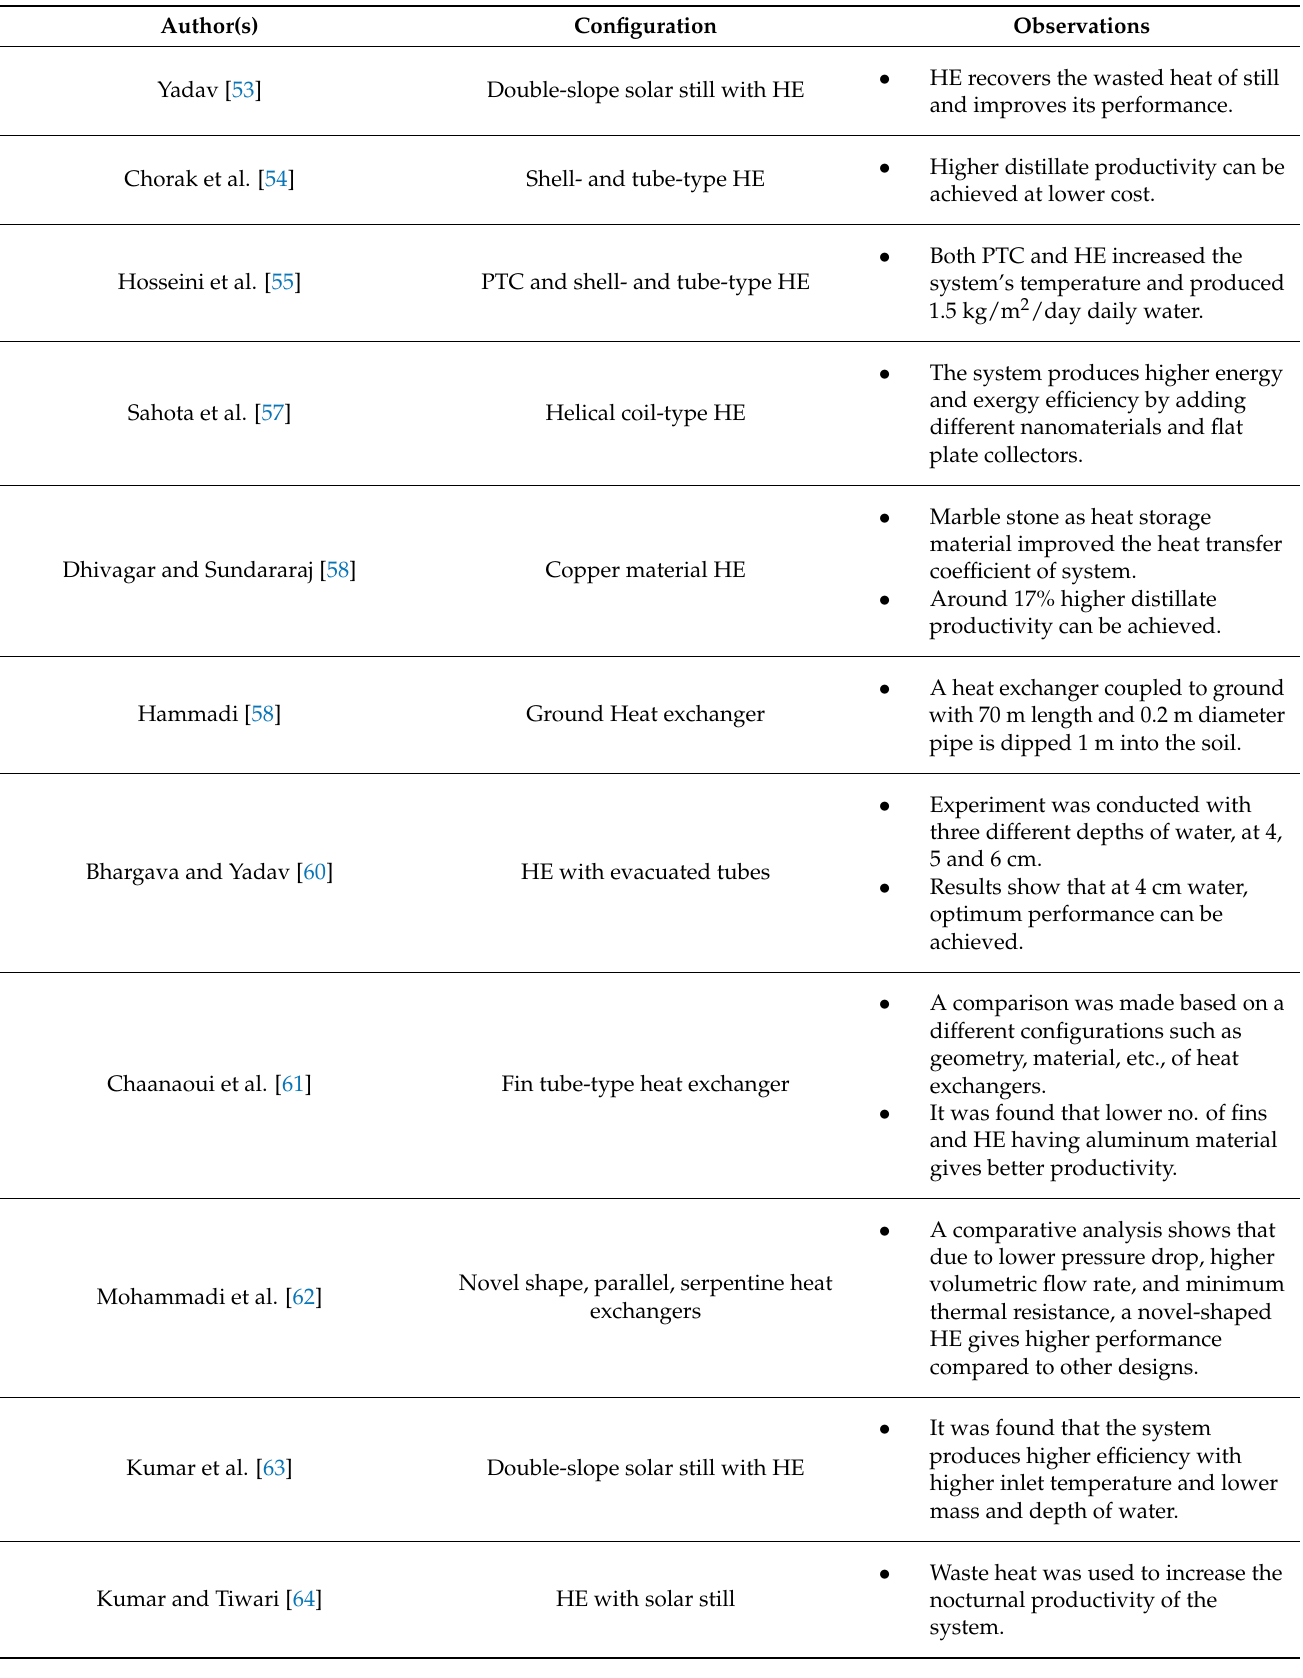
Table 1. Comparison of Different Research Work on solar still with Heat